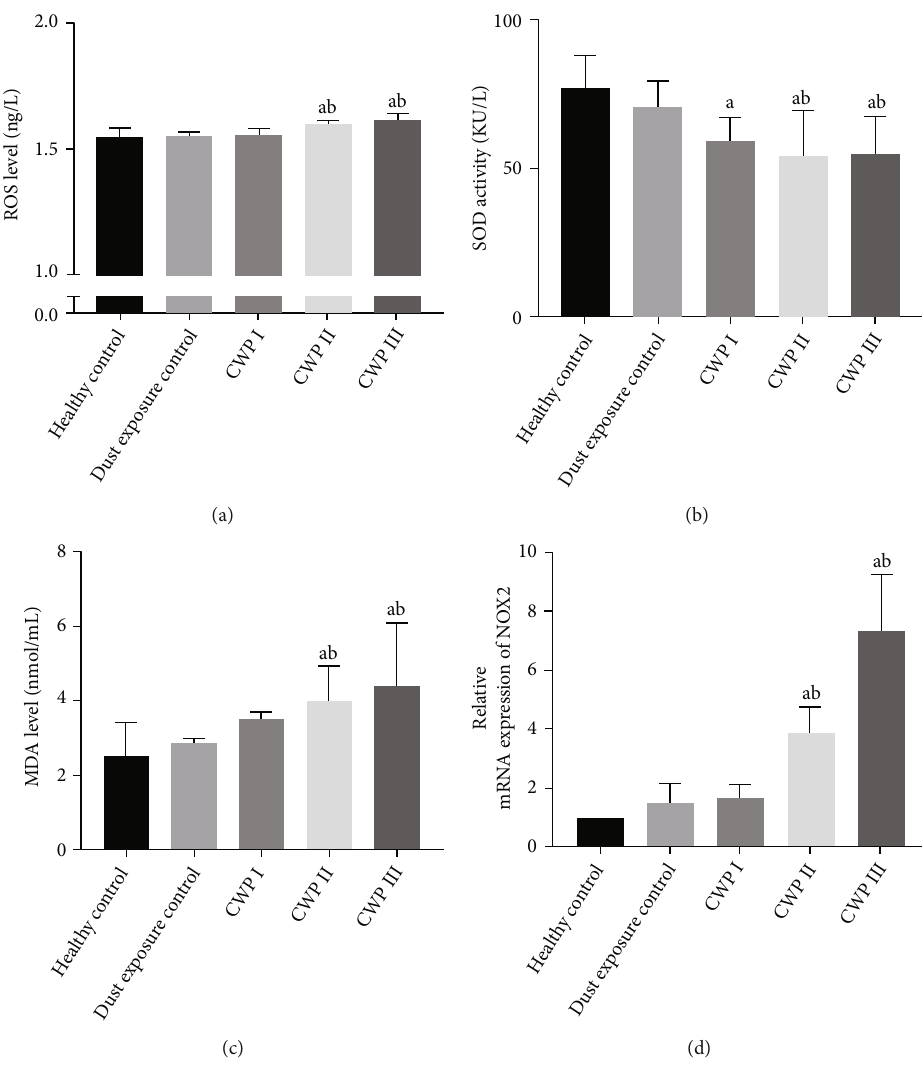
Figure 4: Oxidative damage of coal workers ’ pneumoconiosis changes. (a) The ROS content of human serum samples. (b) The superoxide dismutase (SOD) activity of human serum samples. (c) The malondialdehyde (MDA) content of human serum samples. (d) The relative mRNA expression of NOX2 in human serum samples. a P < 0 : 05 , compared with the healthy control group. b P < 0 : 05 , compared with the dust exposure control